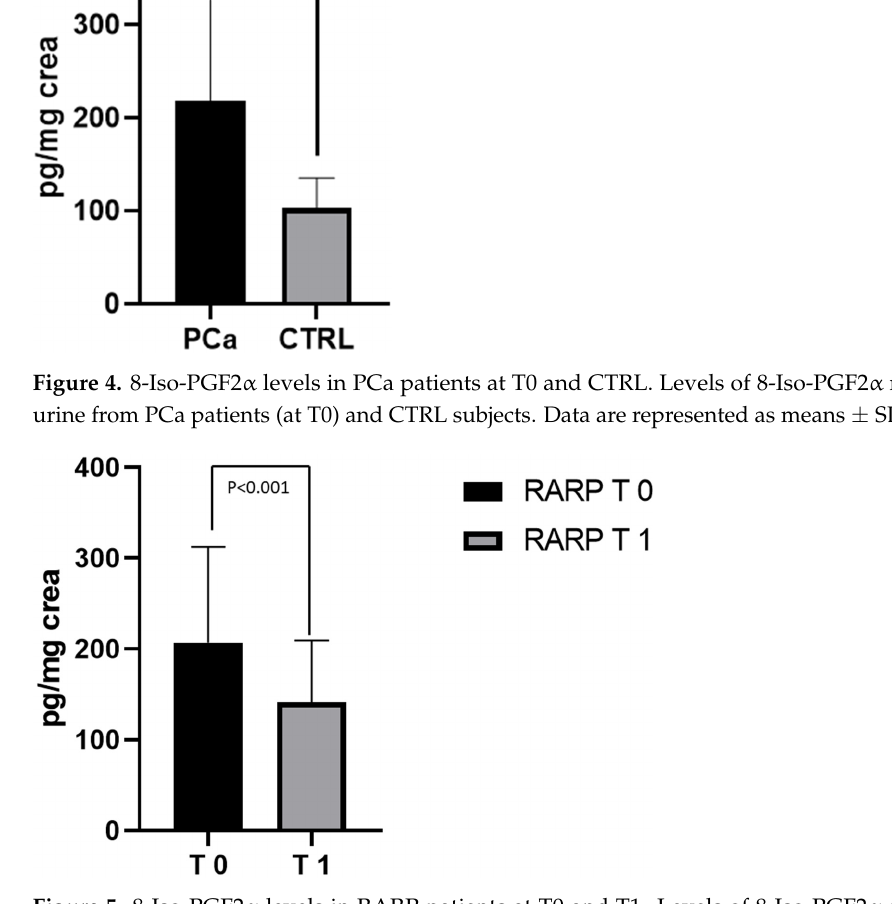
Figure 5. 8-Iso-PGF2 α levels in RARP patients at T0 and T1. Levels of 8-Iso-PGF2 α measured in urine from RARP patients at T0 and T1. Data are represented as means ± SD.